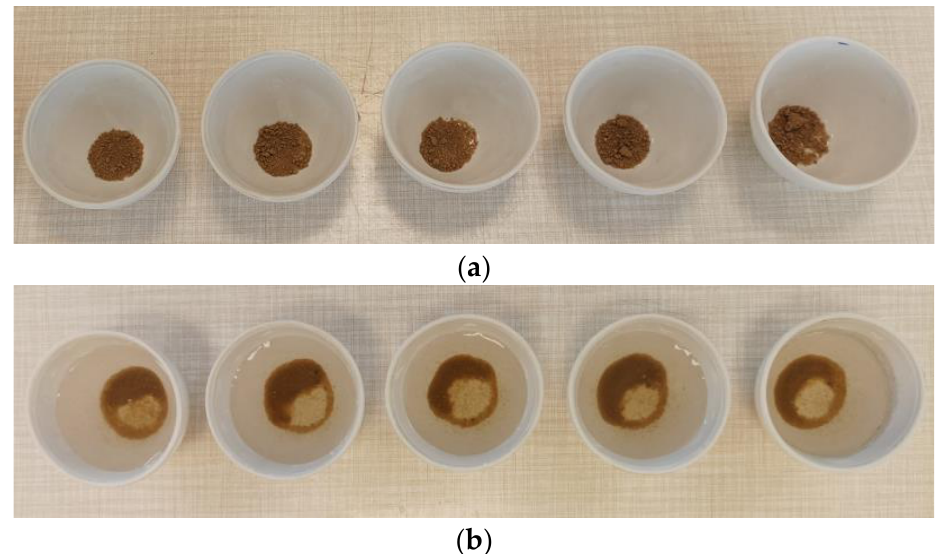
Figure 11. Preparation of silty sand samples for testing in laser particle size analyzer: ( a ) samples of silty sand before pouring distilled water (visible merged grains into compact lumps); ( b ) samples of silty sand after pouring distilled water and waiting for 24 h (separation into individual grains oc- curred).